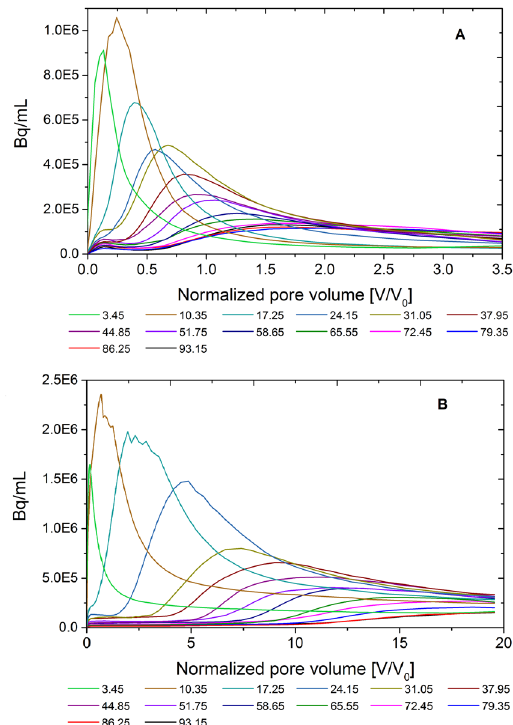
Figure 4. Range of virtual breakthrough curves calculated as average over inner cross-sectional slices with distances of 6.9 mm each along the column, for ( A ) the conservative tracer [ 18 F]KF in column of experiment #2, and ( B ) the reactive tracer [ 64 Cu]Cu(MCPA) 2 in experiment